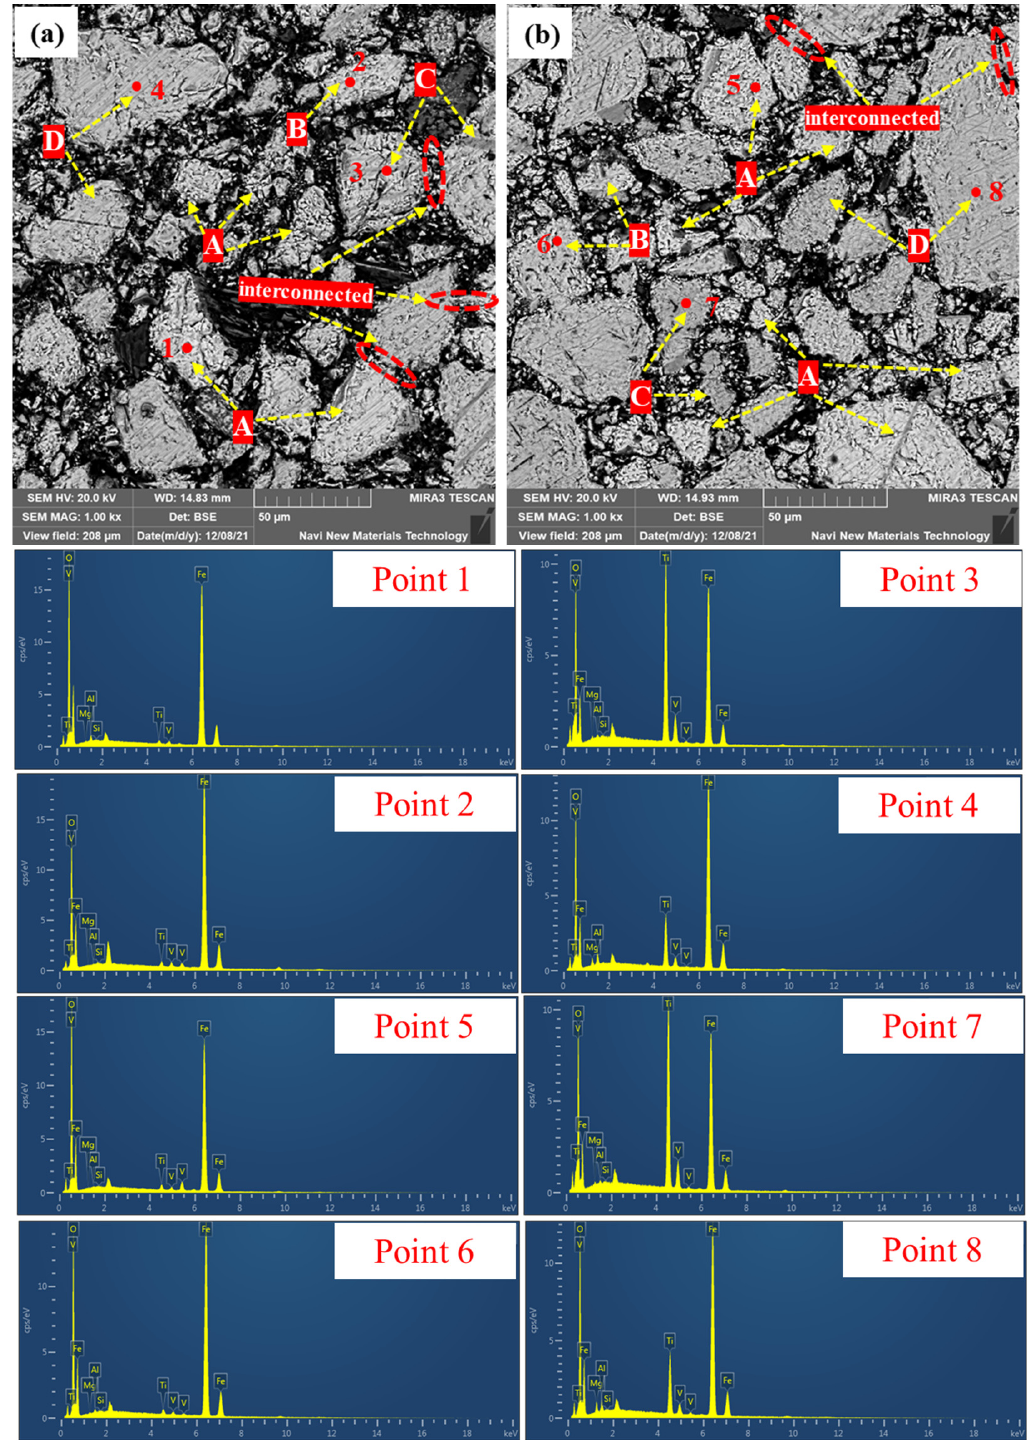
Figure 13. SEM–EDS spectra of the bentonite preheated pellets at different preheating times (( a ) 10 min; ( b ) 16 min). A—hematite; B—magnetite; C—ilmenite; D—titanomagnetite.